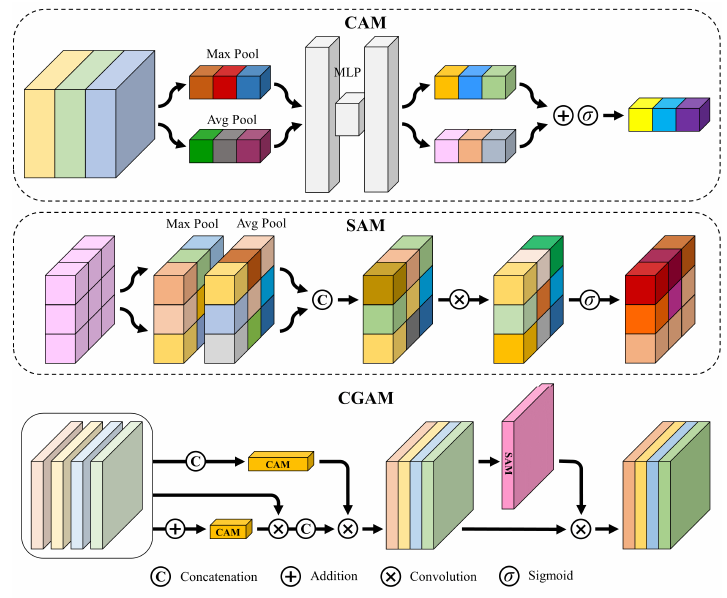
Figure 5. The architecture of